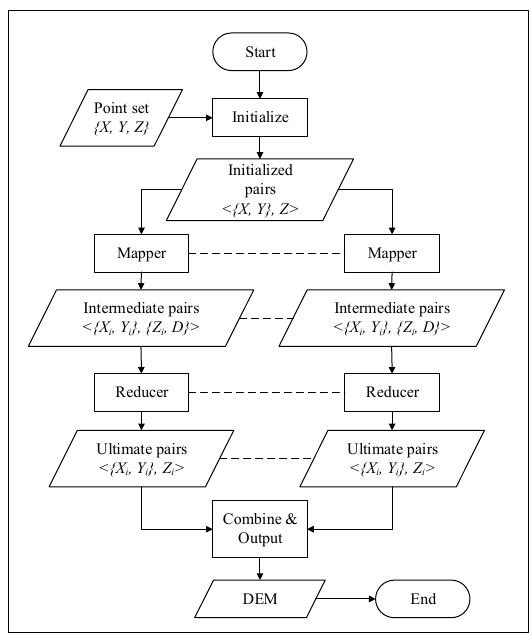
Figure 4. The Hadoop